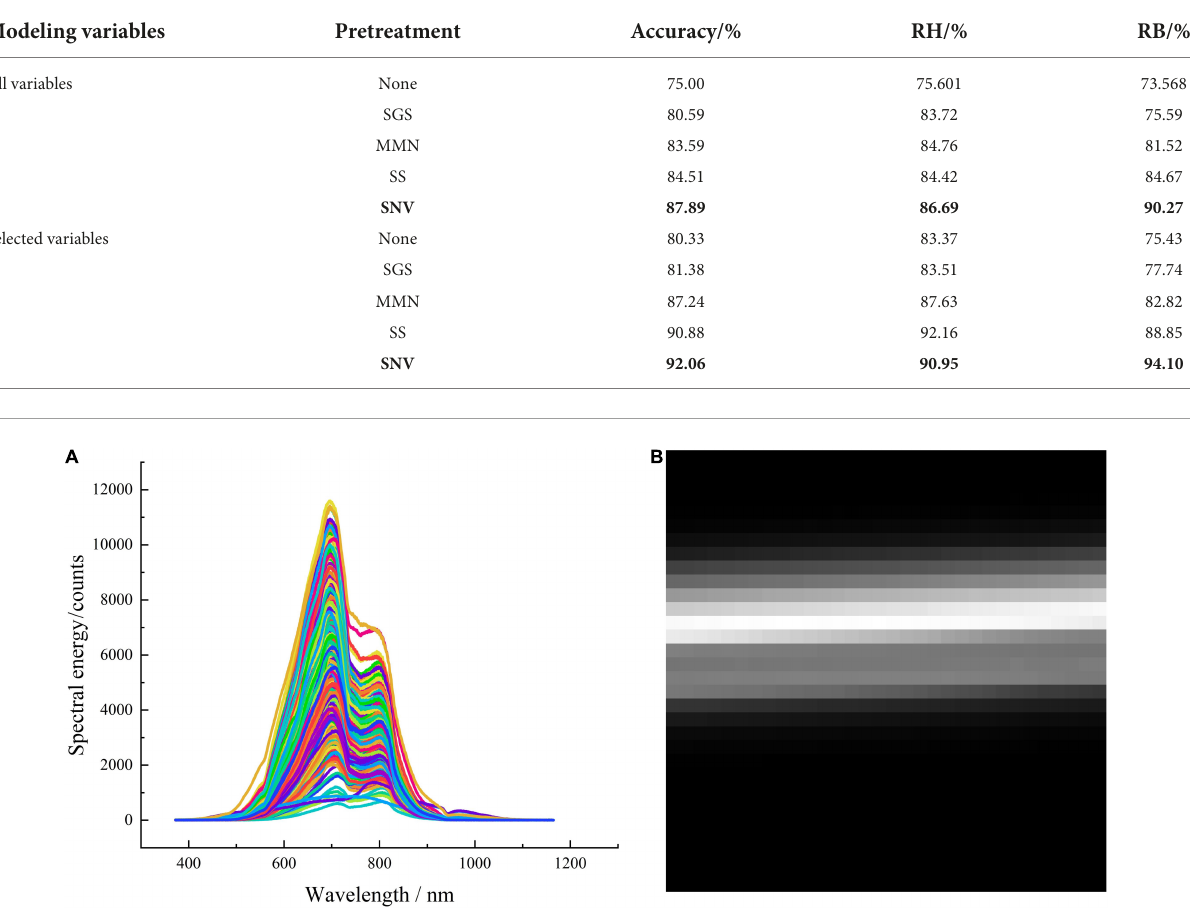
TABLE 3 Calibration results of SVM models based on different pretreatment methods and modeling variables. Modeling variables